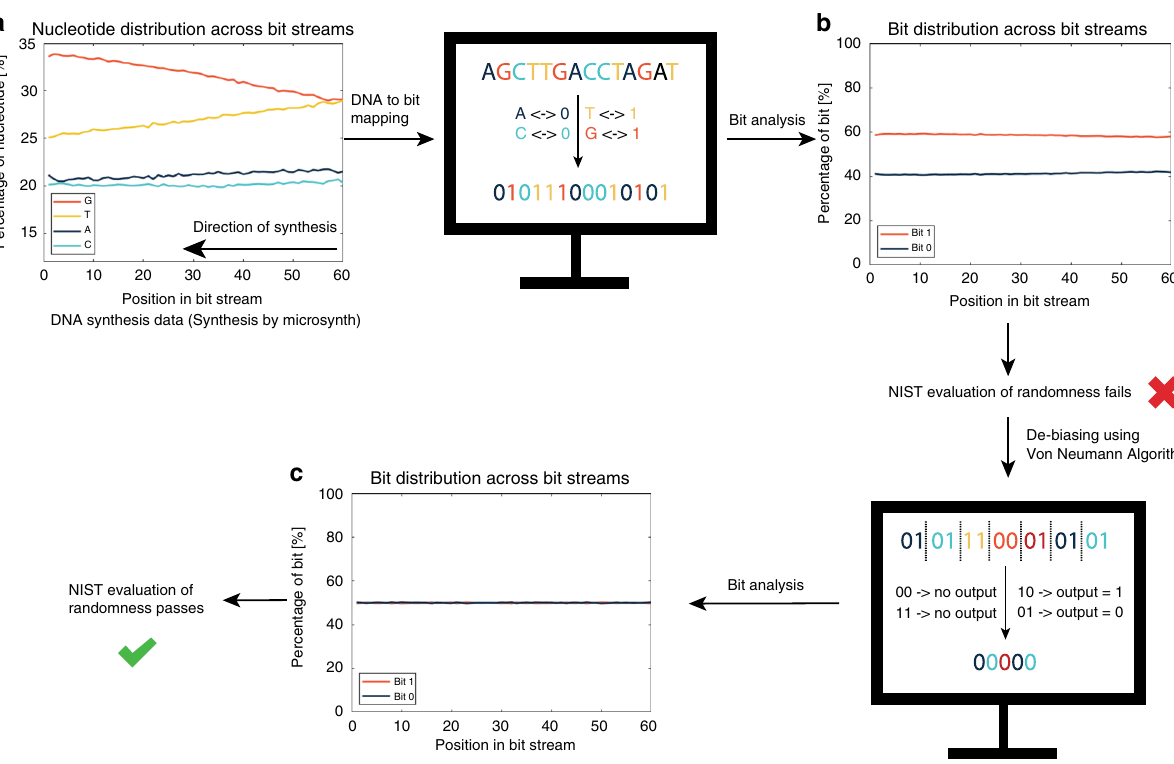
Fig. 5 Process overview. Data processing steps for DNA random number generation. a DNA synthesis by Microsynth (synthesis 1) showing the percentage of nucleotides per position in the DNA segment for the overall pool (see Fig. 3). b Percentage of bits at each position in the bit stream for all sequences in the pool. c Percentage of bits at each position in the bit stream for all sequences in the pool after Von Neumann de-biasing algorithm has been applied. Subsequently to Von Neumann de-biasing, the individual bit streams were combined into a block of bits and then separated into 60-bit streams for better comparison (Supplementary Information 6). Source data are provided in the Source Data fi le. Table 2 Selection of random number generators, the underlying generation methods and randomness production rate in MB/s. Random number generator Randomness production Method rate [MB/s] Meiser et al.